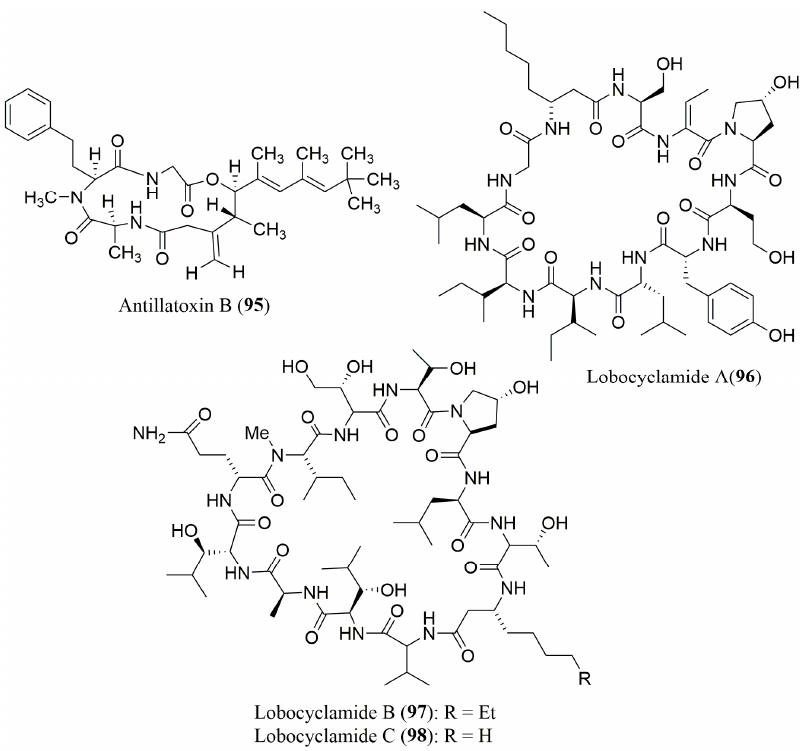
Figure 7. Structure of lipopeptides 95 – 98 , isolated from marine cyanobacteria. Table 3. Lipopeptides from marine cyanobacteria.